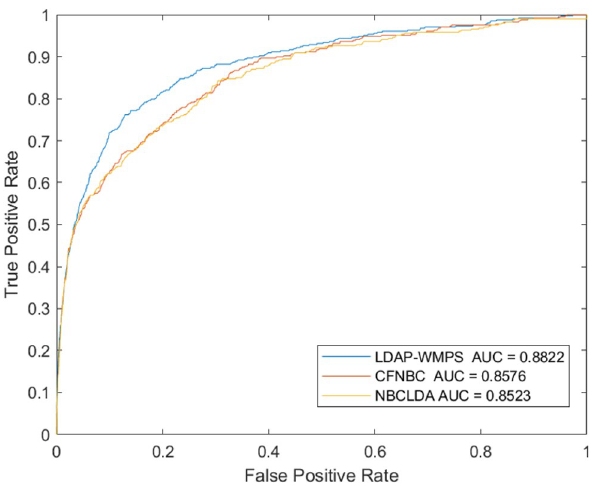
Fig 3. The performance of LDAP-WMPS and others models in terms of ROC curves and AUCs based on 407 known lncRNA-disease associations under the framework of LOOCV.